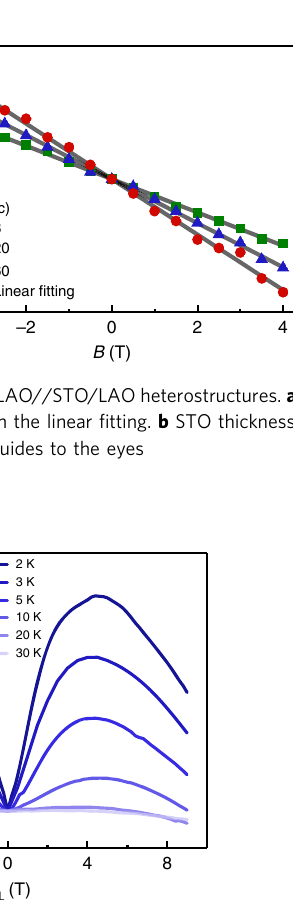
Fig. 4 Temperature-dependent magnetoresistance. Magnetoresistance measured on the LAO//STO/LAO (10//30/10 uc) heterostructure at various temperatures